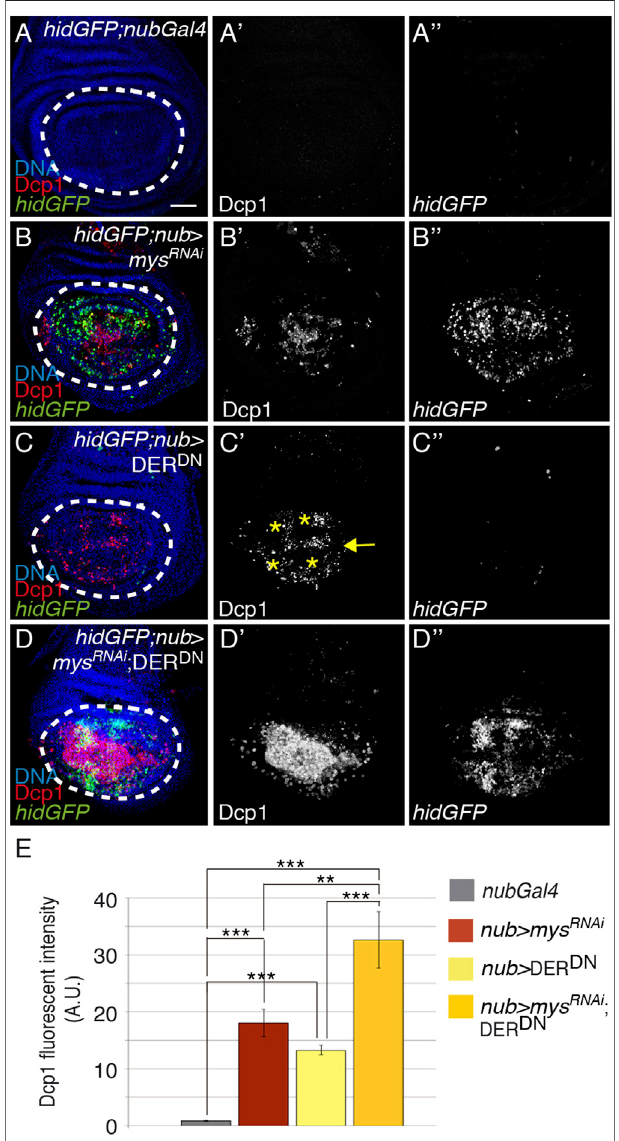
FIGURE 5 | Integrins and EGFR cooperate to promote cell survival. (A – D ” ) Maximalprojectionofconfocalviewsofwingimaginaldiscsfromthird- instar larvae carrying the reporter hidGFP , stained with anti-Dcp1 [red in (A – D) ,whitein (A 9 – D 9 )] ,anti-GFP[greenin (A – D) ,whitein (A ’’– D ’’ )] and the nuclear marker Hoechst [DNA, blue in (A – D) ]. (A – D ’’ ) Control hidGFP ; nubGal4 wing disc. (B – B ’’ ) hidGFP wing disc expressing a mys RNAi under the control of nubGal4 , hidGFP;nub > mys RNAi . (C – C ’’ ) hidGFP wing disc expressing a dominant negative form of the EGFR, DER DN , under the control of nubGal4 , hidGFP ; nub > DER DN . (C – D ’’ ) hidGFP wingdiscco-expressinga mys RNAi and DER DN under the control of nubGal4 hidGFP ; nub > mys RNAi ; DER DN . (E) Quanti fi cation of Dcp1 levels in wing discs of the indicated genotypes. The statistical signi fi cance of differences was assessed with a t -test, ***and** p values < 0.001and < 0.01,respectively.NS,non-statistically signi fi cant. Scale bar in all panels, 30 μ m.